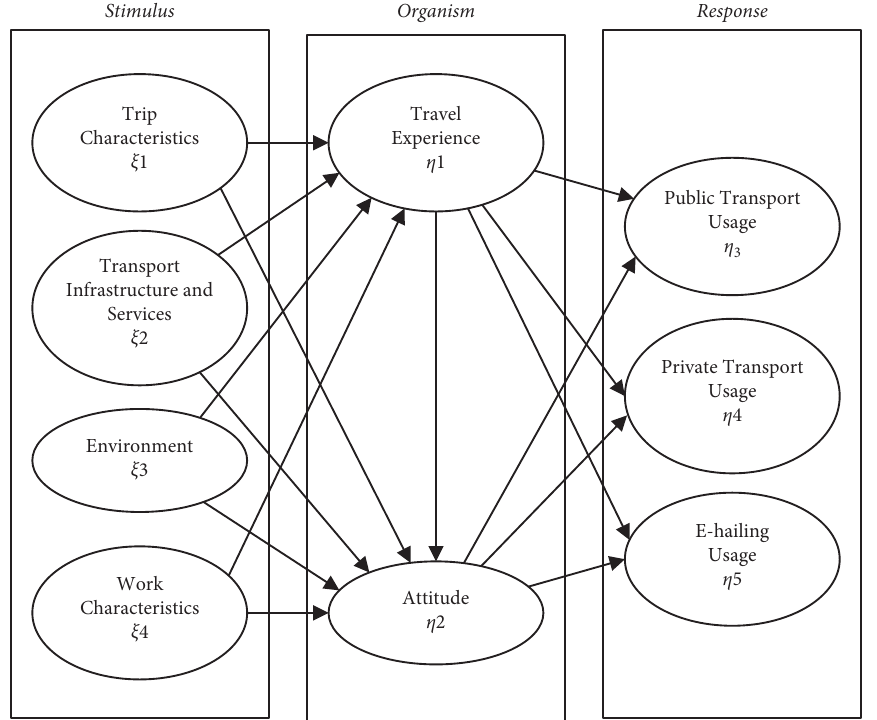
Figure 2: Hypothetical model based on the concept of